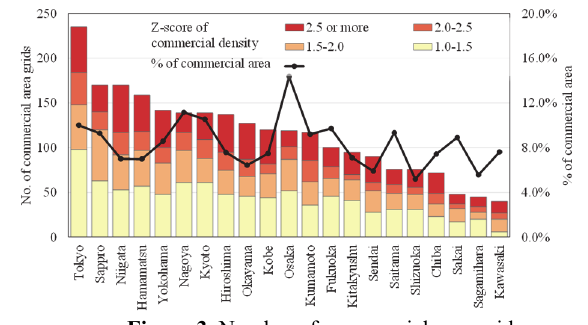
Figure 3 . Number of commercial area grids